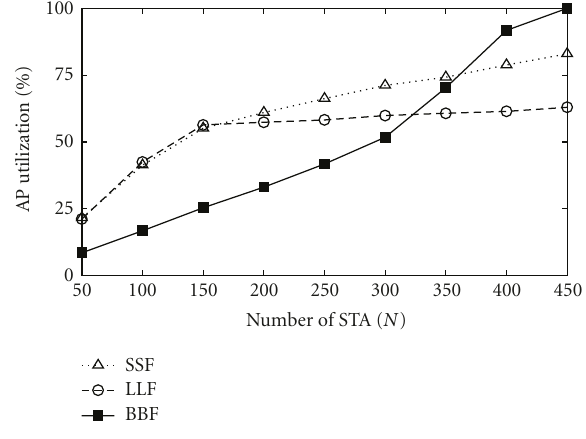
Figure 14: Average bandwidth loaded on an AP.